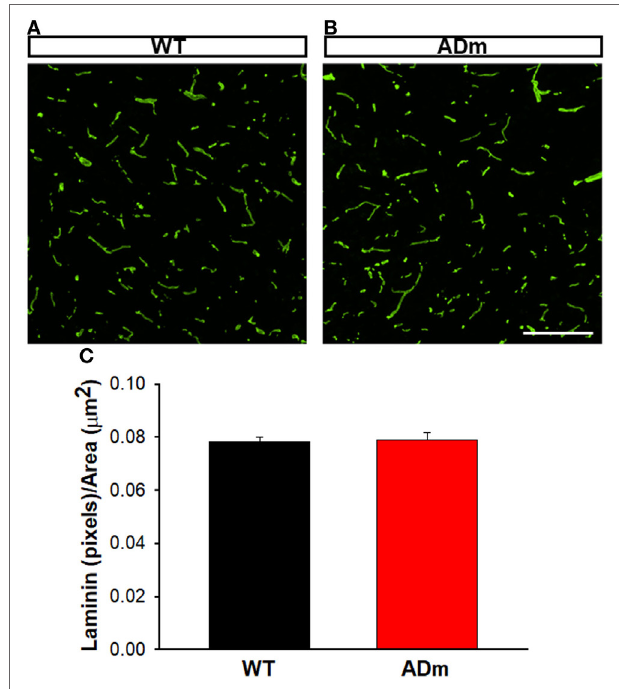
FigUre 4 | Cortical glycosaminoglicans (GAGs) staining. Cortical cryosections from WT mice (a) and ADm mice (B) subjected to RA exposures were stained with Alcian Blue. Scale bar 250 µm. (c) Quantification of the blue pixels (GAGs) per area ( μ m 2 ) in WT tissue (black bar) and in ADm tissue (red bar) using Image J software. Using t -test analysis, no statistical differences between the two groups, WT vs. ADm, were found. Data are presented as mean ± SE. WT, wild type; ADm, Alzheimer’s disease transgenic mouse; RA, room air.